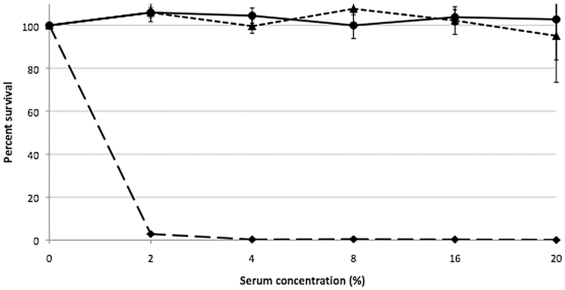
Bactericidal assay of LVSΔ1423/1422 and control strains in the presence of fresh human serum.The bacteria were diluted in PBS supplemented with 0.15 mM CaCl2, 0.5 mM MgCl2, and 2%, 4%, 8%, 16%, or 20% fresh, pooled human serum. Aliquots were cultured by viable plate count before and after 60 min. incubation at 37°C. Bacterial strains: LVS, _____•_____; LVSΔ1423/1422, ---▴---; O-antigen mutant WbtIG191V_P17, __ __
♦__ __.